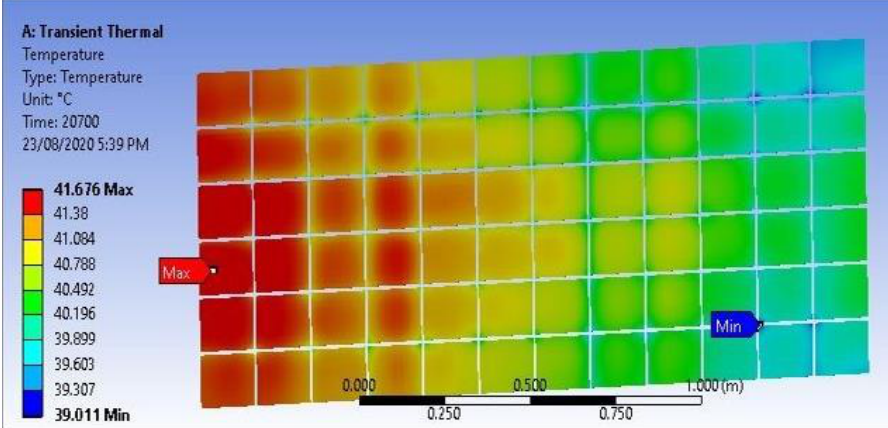
Figure 16. Simulated contours of the hybrid solar panel system.